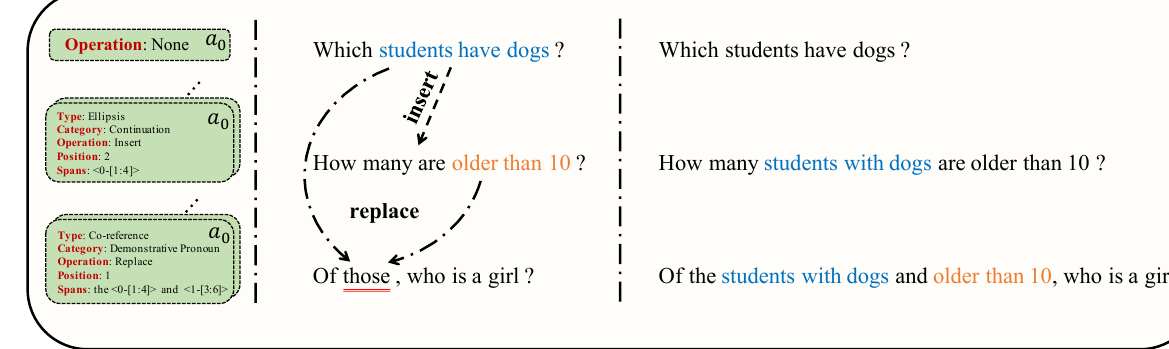
Figure 1. Overview of the annotations in